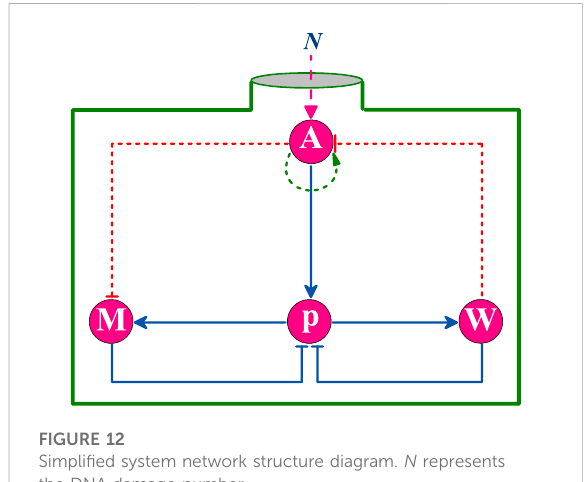
The dependence of r PM on [P] under anti-competitive inhibition. Without losing generality, K m = 0.5, r max = 1.0, K M = 0.5 and [M] = 1.0. So, K m * (cid:2) 0 . 167, r max * (cid:2) 0 .